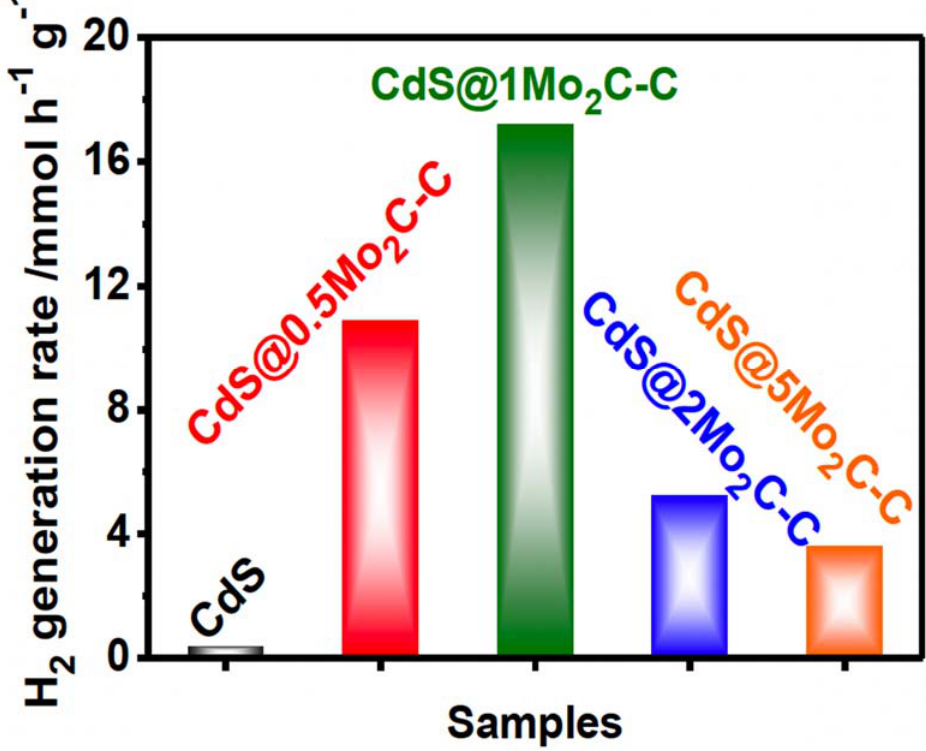
Figure 19. Photocatalytic hydrogen generation activities on CdS and CdS@xMo 2 C-C (x = 0.5, 1, 2, and 5, where x refers to the theoretical weight percent value of Mo 2 C). Reproduced with permission from reference [135].